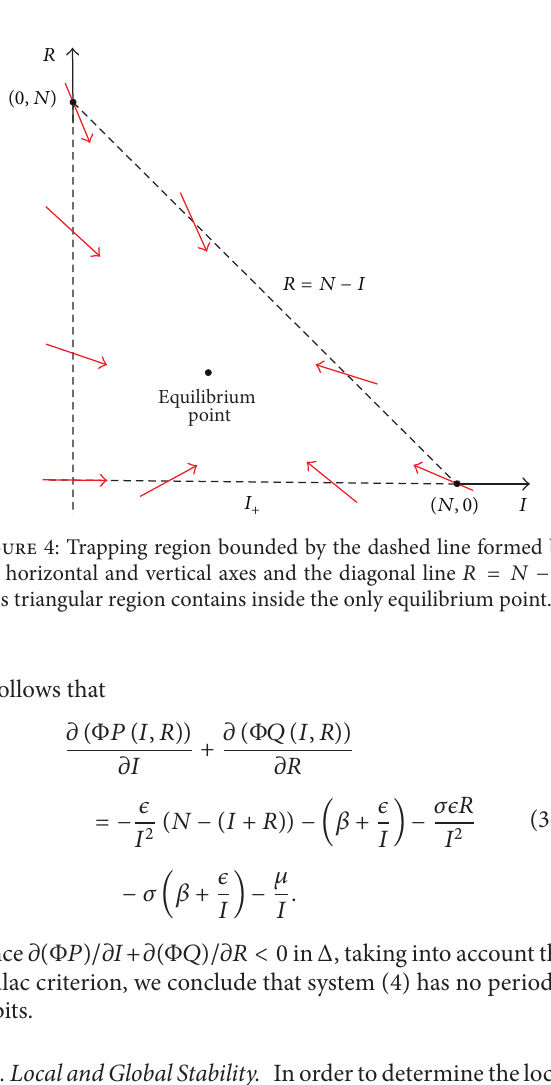
Figure 3: Schematic representation of a branch of the vertical nullcline 𝐺 1 (𝐼) (dashed line) and the horizontal nullcline 𝐺 2 (𝐼) (solid line). Both curves intersect in Δ once at the equilibrium point.